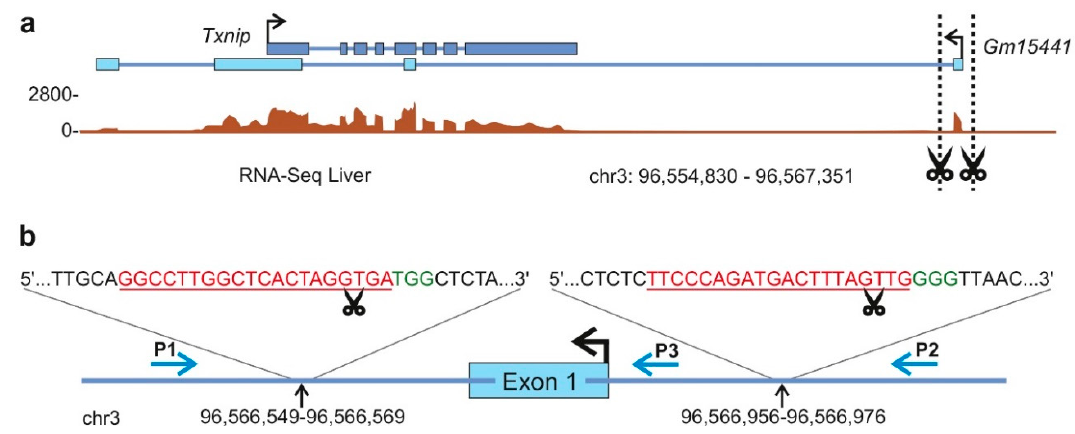
Figure 1. Targeting strategy: ( a ) Schematic illustration of the targeting strategy to delete exon 1 of long noncoding RNA (lncRNA) Gm15441 . Brown histograms represent RNA-Seq read counts in livers of 30-week-old C57BL/6 mice. Blue boxes indicate annotated exons of lncRNA Gm15441 (light blue) and overlapping protein-coding gene Txnip (dark blue). Dotted lines show genomic sites to be cleaved by clustered regularly interspaced short palindromic repeats (CRISPR)/Cas9-mediated genome engineering. ( b ) Schematic representation of the targeted Gm15441 locus. Spacer sequences of Cas9-recruiting CRISPR RNAs (crRNAs) are shown in red. Protospacer adjacent motifs necessary for Cas9 activity are shown in green. Black arrows indicate the genomic coordinates bound by crRNA spacer sequences. Scissors depict Cas9 cutting sites. Blue arrows indicate polymerase chain reaction (PCR) primers P1, P2 and P3 used for genotyping and sequencing.